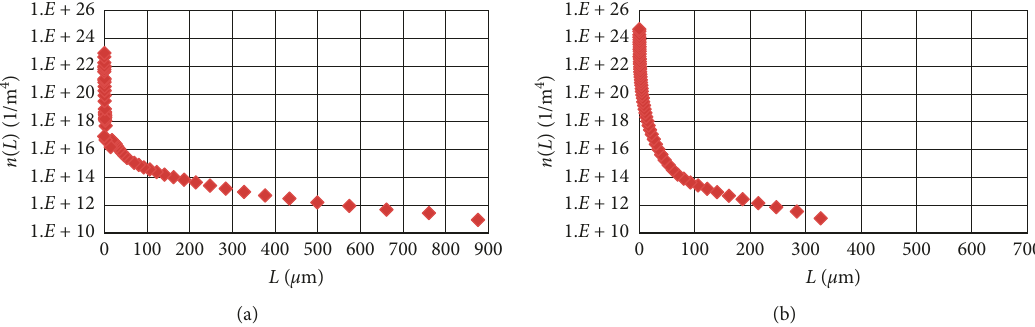
Figure 13: Population density n